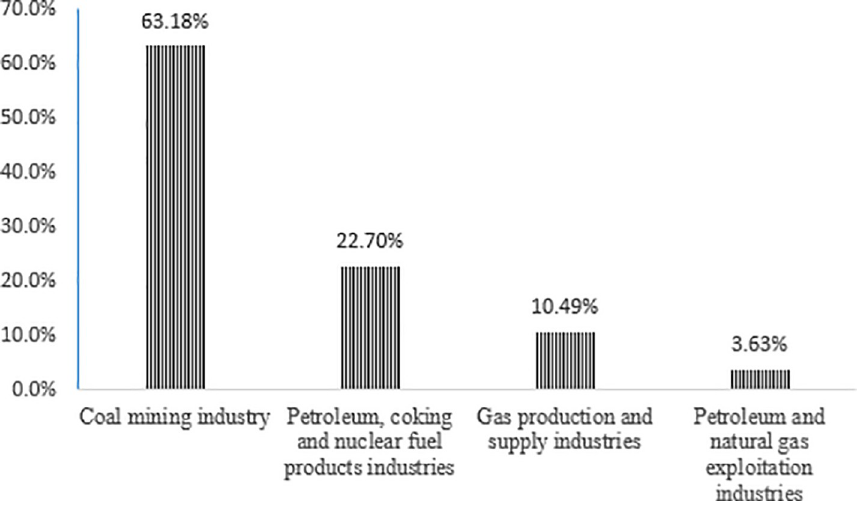
Fig 2. Proportion of carbon emissions from four types of disposable